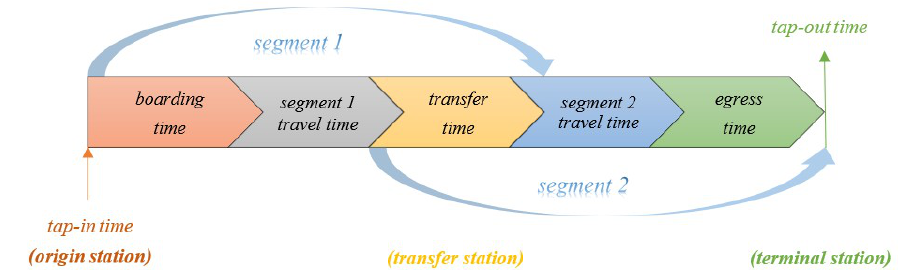
Figure 1. Flow chart of a one-transfer metro